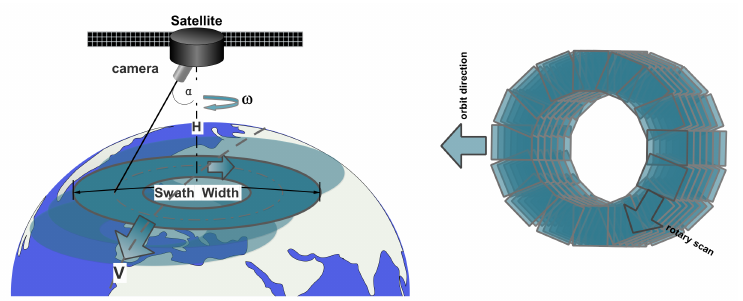
Figure 1. The imaging process with the LEO plane array rotary scan space camera. In which α is the camera’s tilt angle, H is the orbit height, ω is the rotating angular speed of the camera, and SW is the swath